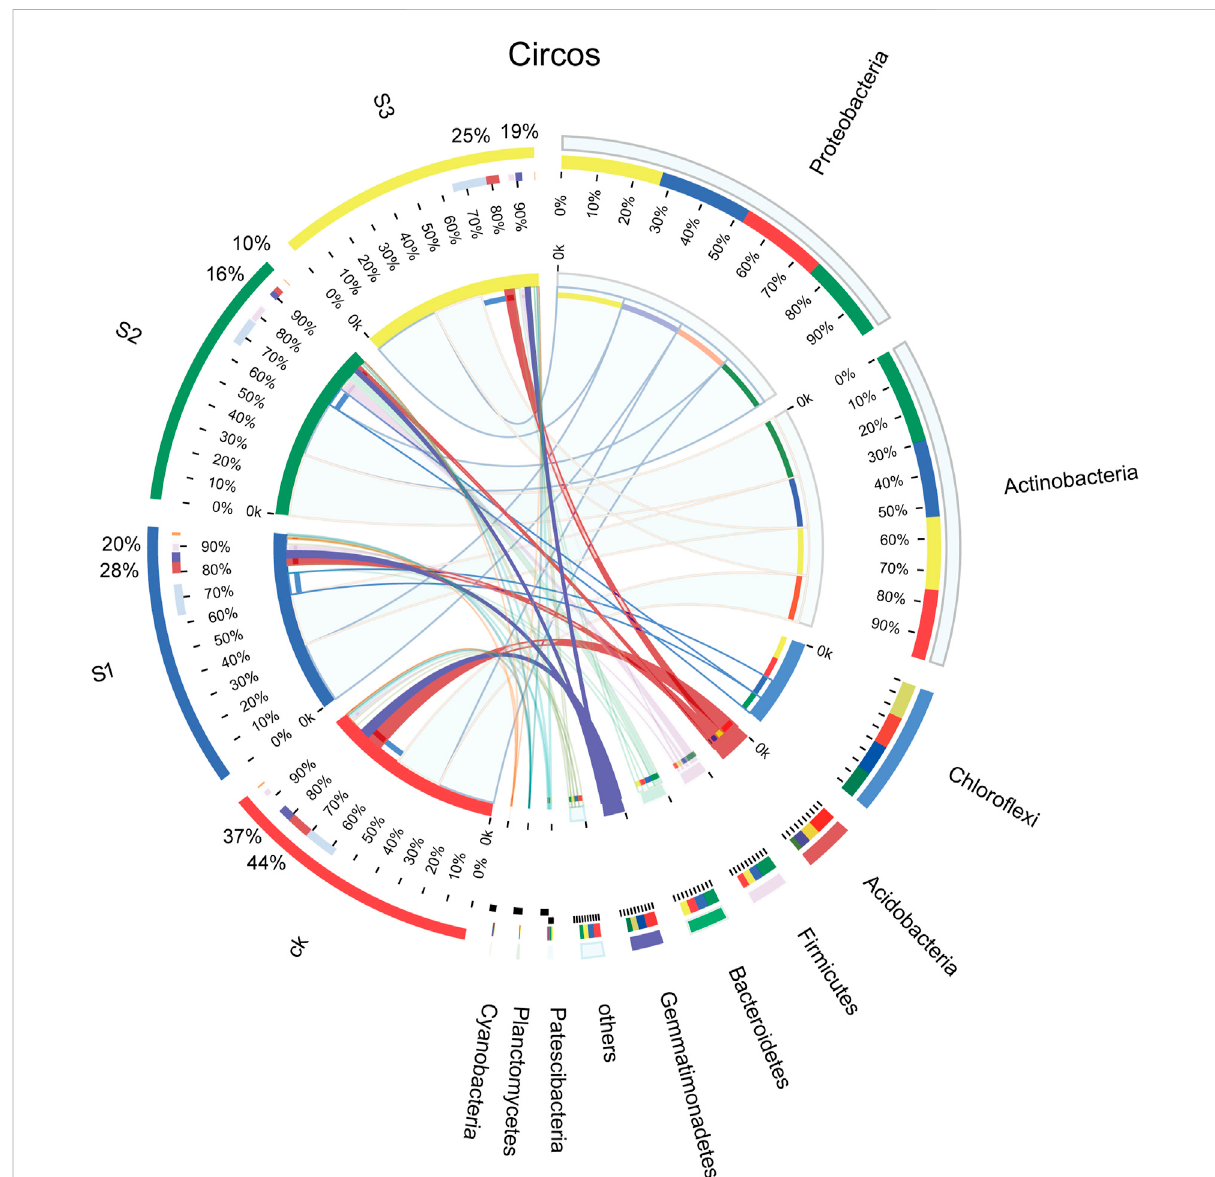
FIGURE 4 Relativeabundanceofbacteriafromdifferentcommunitiesatthephylumlevel.Thepurple-redbandis Acidobacteria ,andtheblue-purpleband is